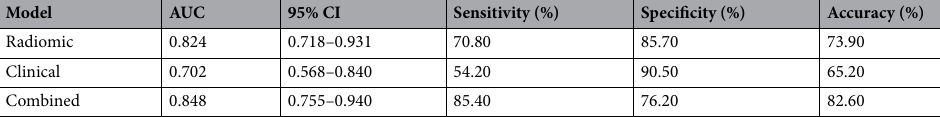
Table 3. Area under receiver operating characteristic curve, sensitivity, specificity and accuracy of the predictive models for pain response.